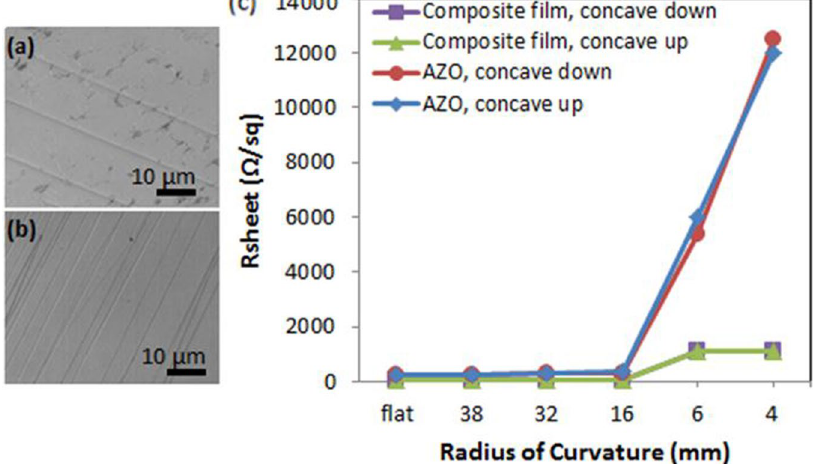
Figure 6. SEM micrographs at R = 6 mm of ( a ) the Ag NW/AZO composite contact and ( b ) the AZO film under tensile strain. ( c ) R sheet values as a function of tensile and compressive strain